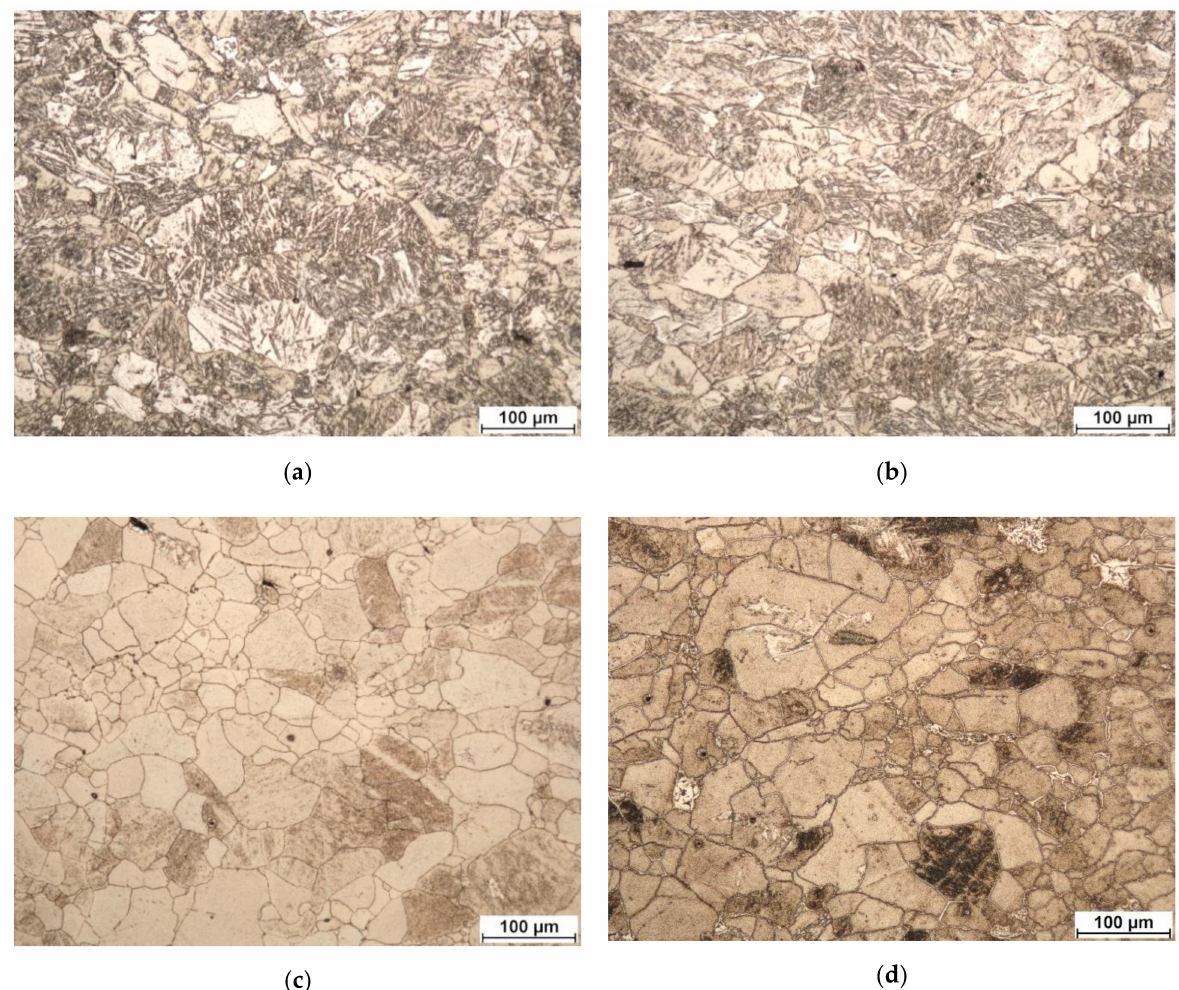
Figure 5. Microstructure of zirconium spark plasma sintered at 800 ◦ C with various cooling rates and subsequent heat treat- ment at: ( a ) 400 ◦ C/min; ( b ) 10 ◦ C/min; ( c ) 400 ◦ C/min + heat treatment at 580 ◦ C and holding at 120 min; ( d ) 400 ◦ C/min + heat treatment at 750 ◦ C and holding time at 30